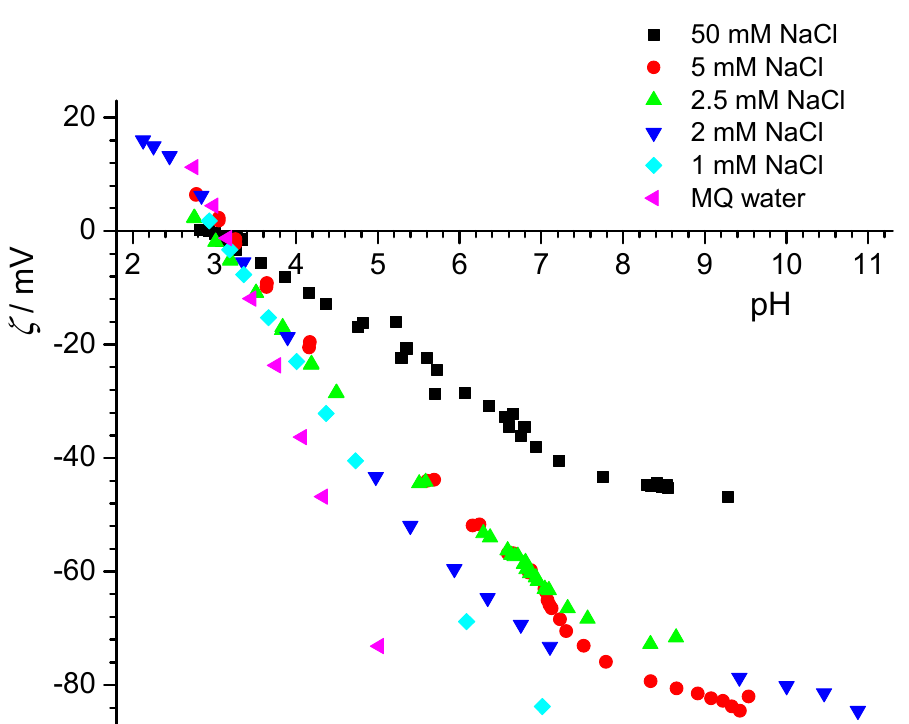
Figure 9. Electrokinetic potential of PTFE flat surfaces in NaCl(aq) solution and pure water, θ = 25 ◦ C. The results for 2 mM NaCl were obtained in Zagreb for a different source of PTFE.